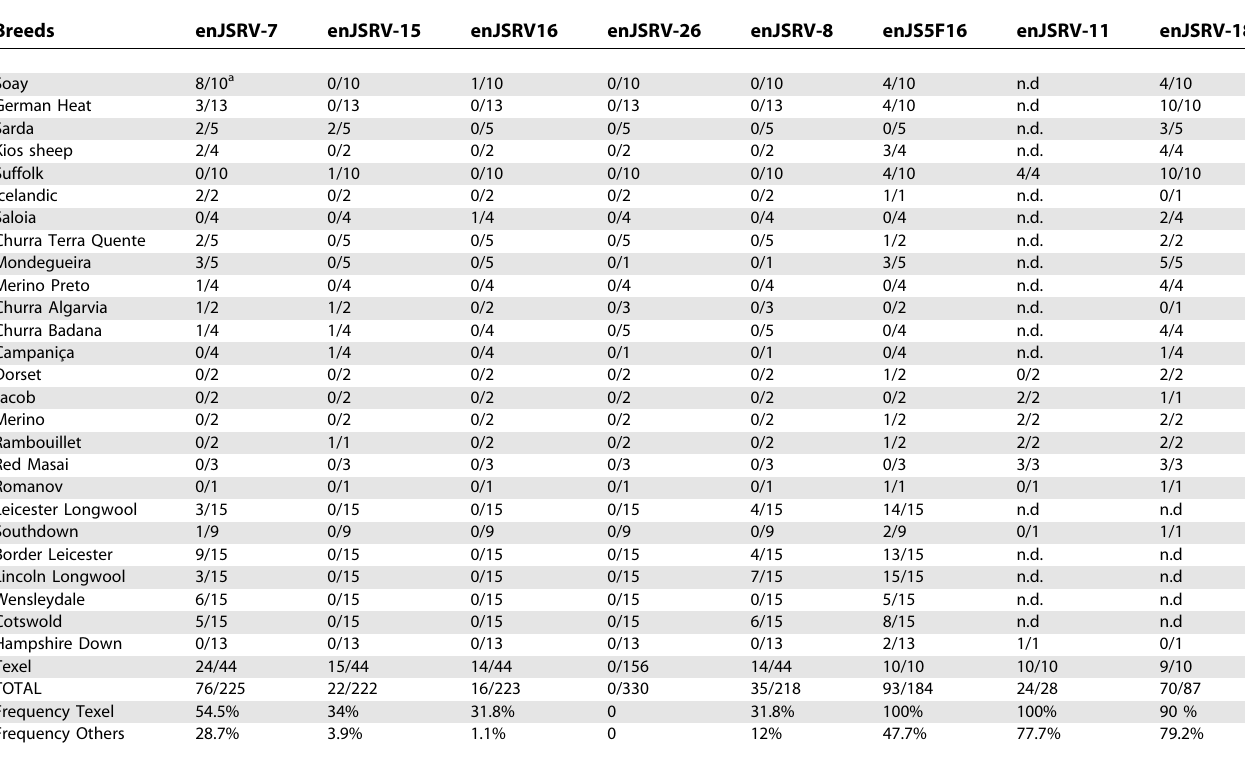
Table 1. Relative Frequency of Insertionally Polymorphic Proviruses in Sheep